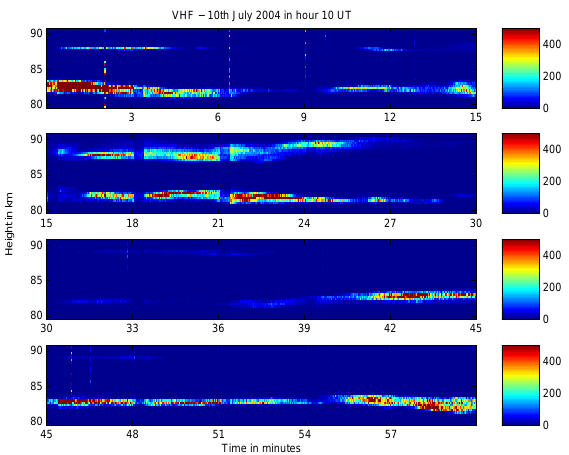
Fig. 4. One hour of raw data of PMSE during one hour on 10 July 2004. In this case the heater transmitter power is at full power on the heater cycles starting at 0m, 15m, 30m and 45m while it is reduced in steps of 20% of the full power, at each subsequent heater cycle, down to 20% of full power and then returned to full power.